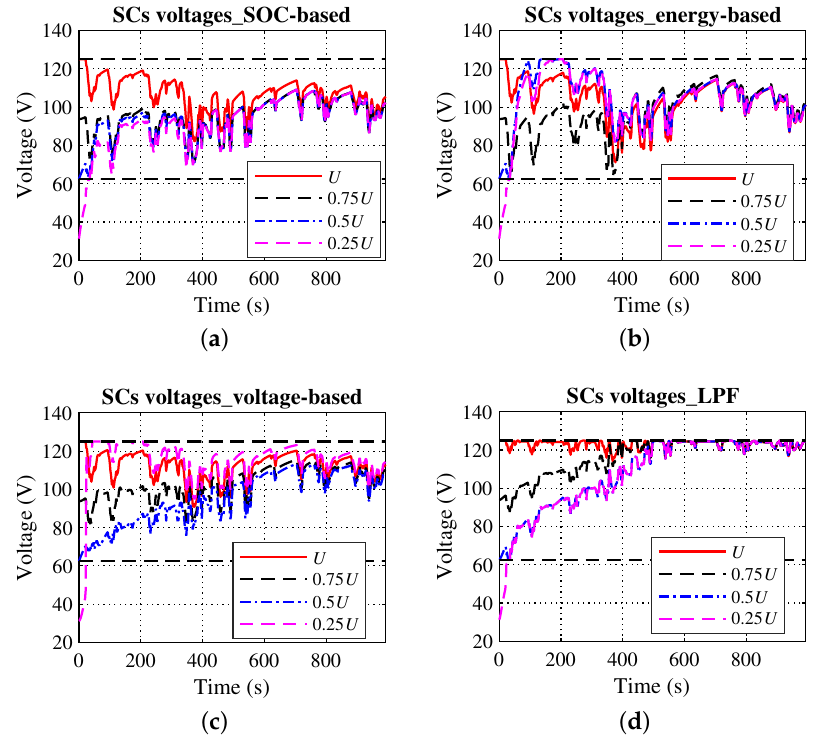
Figure 15. SC voltages with the studied strategies in the UADC: ( a ) SOC-based strategy; ( b ) Energy- based strategy; ( c ) Voltage-based strategy; ( d ) Conventional filtering strategy.